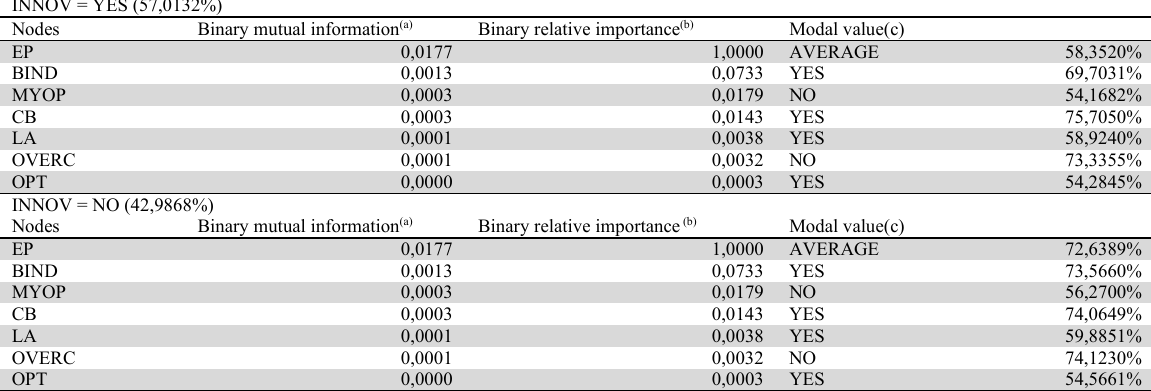
Target variable